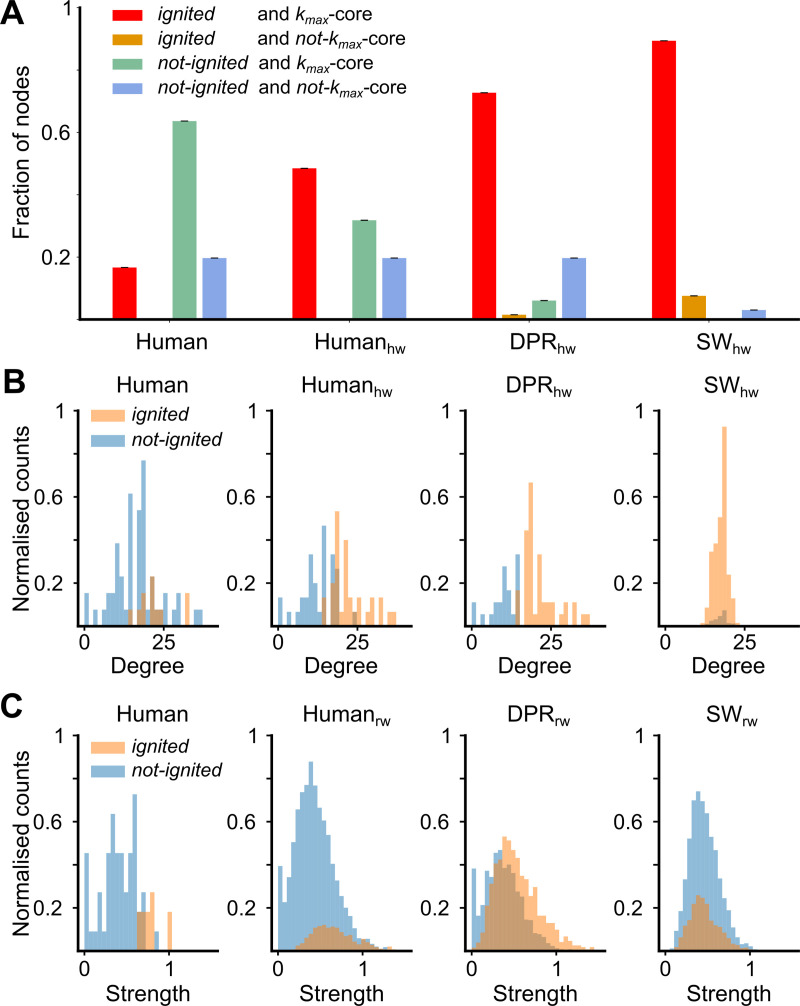
Ignited cortical areas are loosely related to other organization features at the ignition point.(A) Fraction of nodes which are ignited (red, orange) or not-ignited (green, blue) at G-, and that belong to kmax-core (red, green) or not (orange, blue). Note that the kmax-core nodes match with all the ignited in the Human, but also with a large number of nodes with baseline activity (not-ignited). (B) Degree distribution of ignited (orange) and not-ignited (blue) nodes at the ignition point G-, for Human and the wSCs. (C) Strength distribution of ignited (orange) and not-ignited (blue) nodes at the ignition point G-, for Human and the wSCs.